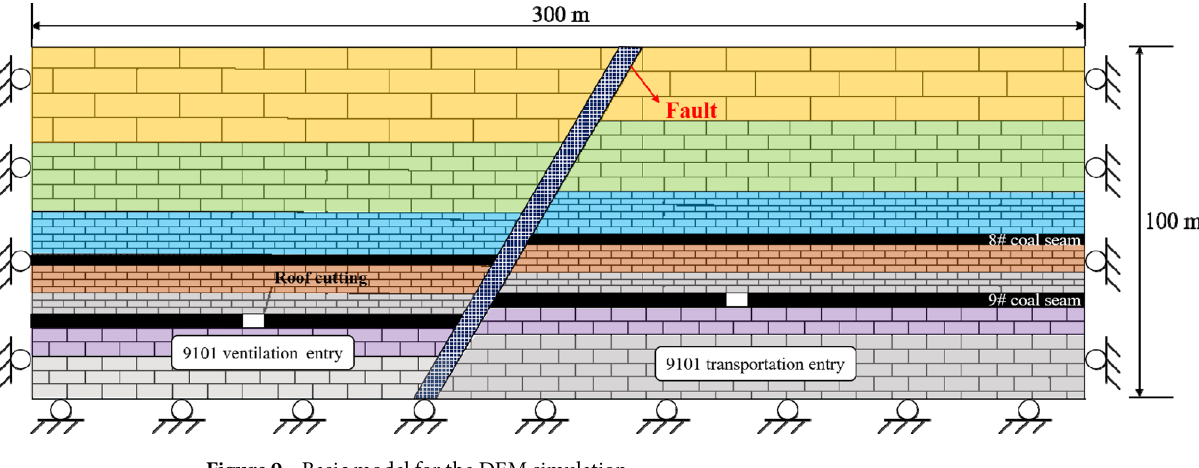
Figure 9. Basic model for the DEM